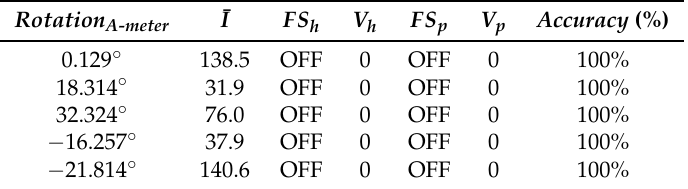
Table 4. Results of using the A-meter YF-370A with the function select “OFF”. Rotation A-meter